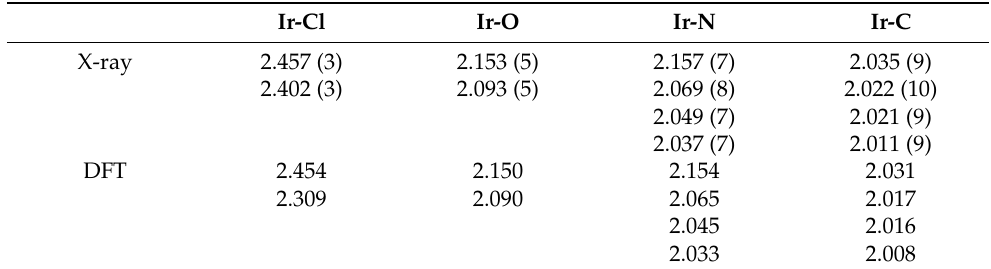
Table 2. Comparison of selected bond lengths (Å ) and angles (°) of 1 from crystallography and DFT calculation.